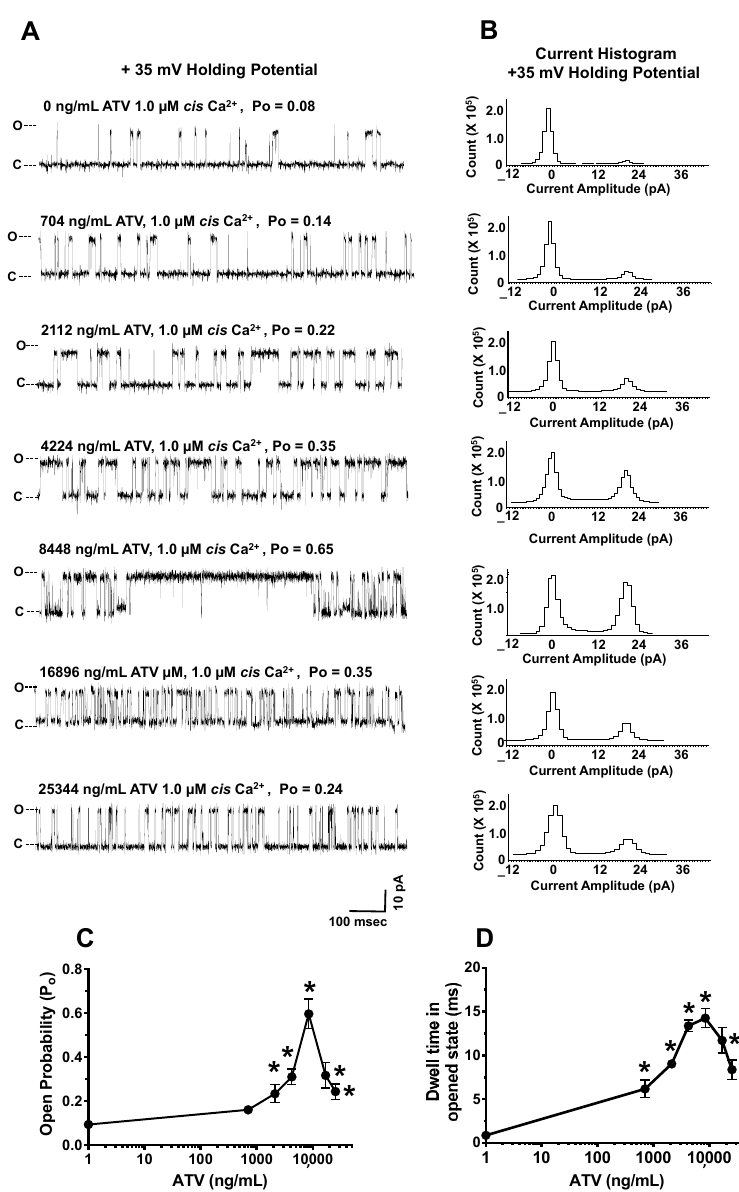
Figure 3. Effects of increasing cis concentrations of atazanavir (ATV) on the open probability of RyR2. Panel A shows a representative 1.0 s recording of a RyR2 channel with 1.0 µ M cis Ca 2+ and cumulative amounts of cis ATV. Panel B shows the current histograms for the channel with cumulative amounts of cis ATV. Panels C , D are graphs of the open probability and dwell time (mean ± SD) of RyR2 as a function of the cis concentrations of the ATV channels for n = 13 channels. The recordings shown are at +35 mV (upward deflections) in a symmetric KCl buffer solution (0.25 mM KCl, 20 mM K/HEPES, pH 7.4). O, open; C, closed. * denotes significantly different ( p < 0.05) from the control (before the addition of the